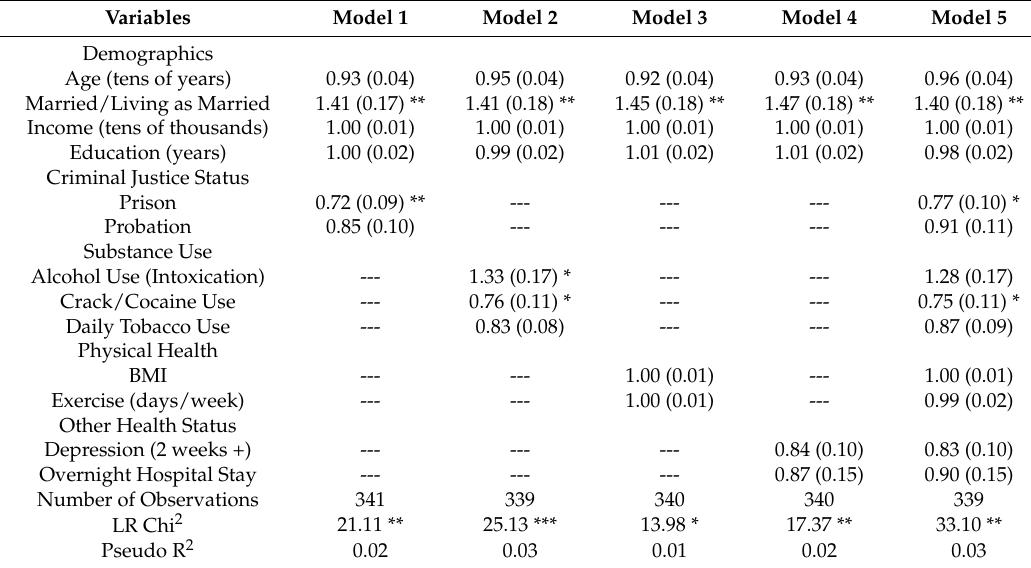
Table 3. Poisson regression predicting health matters network size at follow-up with baseline demographic and health status/behavior